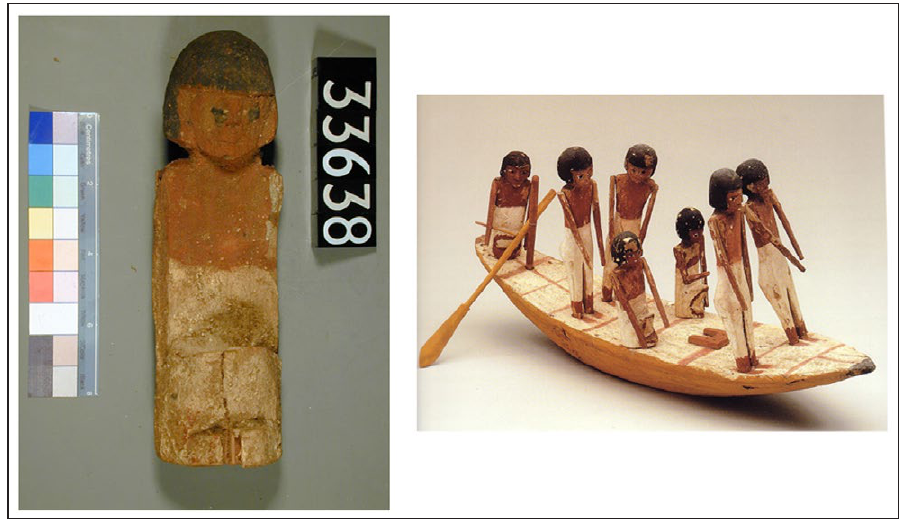
Figure 2: UC33638 (Courtesy of the Petrie Museum of Egyptian Archaeology, UCL) compared with a boat from tomb 2127 (National Museum of Denmark 7546) (cf. Jorgensen et al. 2002: